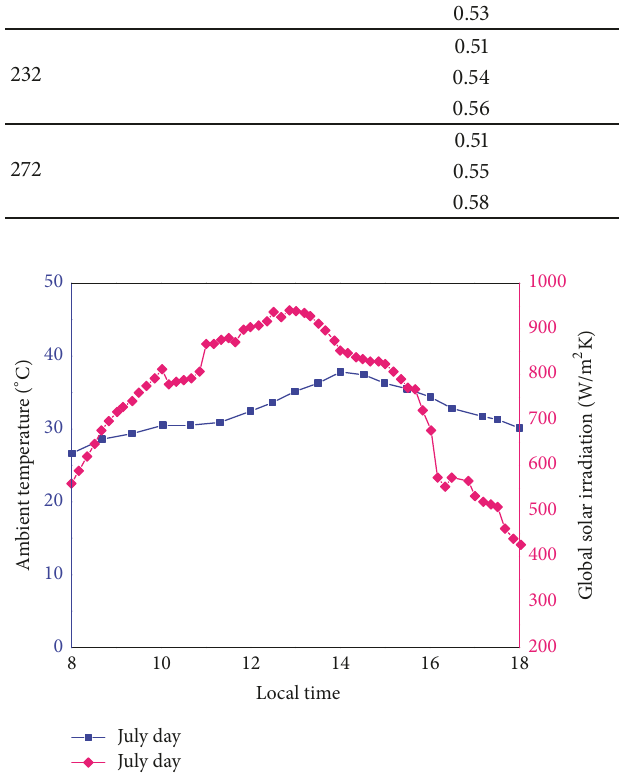
Figure 7: Evolution of solar radiation and ambient temperature in a typical summer day (July 16) in Tunis-Tunisia [18].